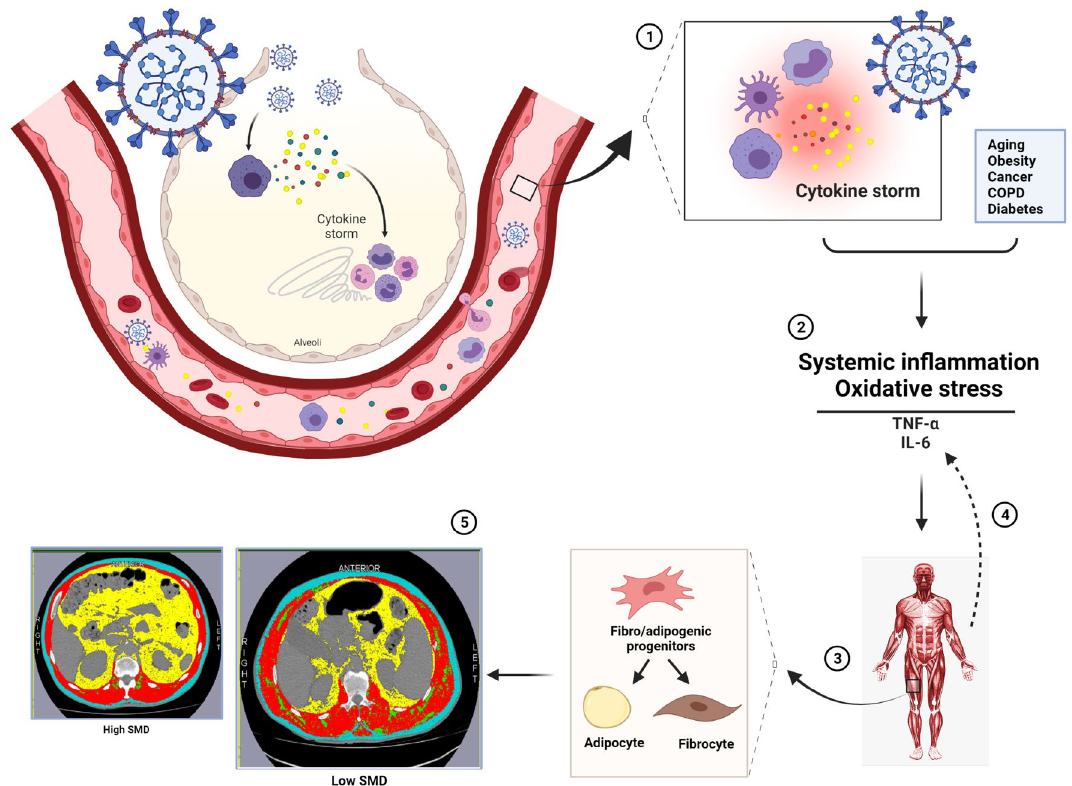
Figure 5. Proposed pathophysiology for low muscle radiodensity in COVID-19. 1. COVID-19 infection and increased inflammatory response (cytokine storm); 2. Systemic inflammation and oxidative stress due to COVID-19 and underlying comorbidities with high levels of circulating cytokines (e.g., IL-6 and TNF-α) and high NLR; 3. Fibro-/adipogenic progenitors in skeletal muscle differentiate into fibrocytes and adipocytes; 4. Myositis increases cytokine release; and 5. Increase in intramuscular adipose tissue leading to low SMD. Abbreviations: COPD: Chronic obstructive pulmonary disease; IL-6: Interleukin 6; NLR: Neutrophil ‐ to ‐ lymphocyte ratio; SMD: Skeletal muscle radiodensity; TNF-α: Tumor necrosis factor